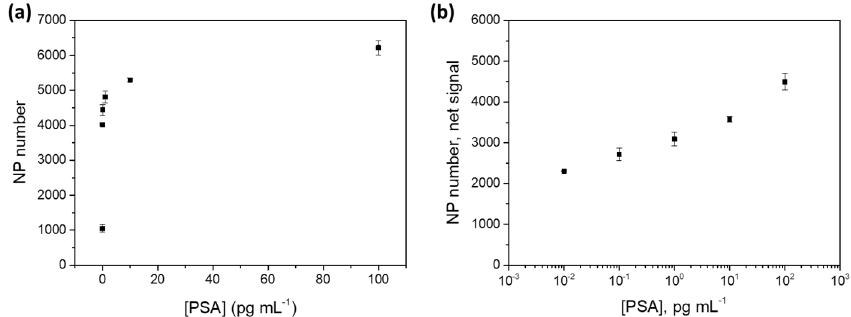
Figure 7. ( a ) Immunoassay response curve obtained after image processing of gold-amplified Mn-ZnS QD confocal microscopy images at the di ff erent PSA concentrations collected in Figure 6. ( b ) Immunoassay response curve linearized by applying Ln to the x -axis. Error bars correspond to 1SD of the two di ff erent zones measured in the same well. The corresponding calibration equation is: 228.07 Ln [PSA] + 3237.4; r 2 = 0.966. Table 1. Analytical performance characteristics of di ff erent biosensors for ultrasensitive PSA detection.